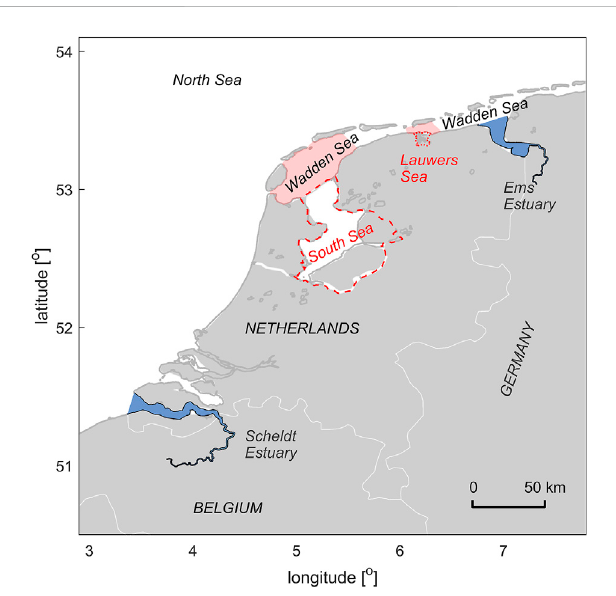
FIGURE 1 Overview of the intervened coastal systems studied in this paper: the two tidal basin closures in the Wadden Sea (Lauwers and South Sea, both indicated with red dashed lines), the Ems Estuary and the Western Scheldt (in blue). The South Sea was connected with the Western Wadden Sea (shaded red); the Lauwers Sea with the Zoutkamperlaag basin (shaded red as well). Both the Ems and Scheldt estuary are drawn exactly up to the tidal